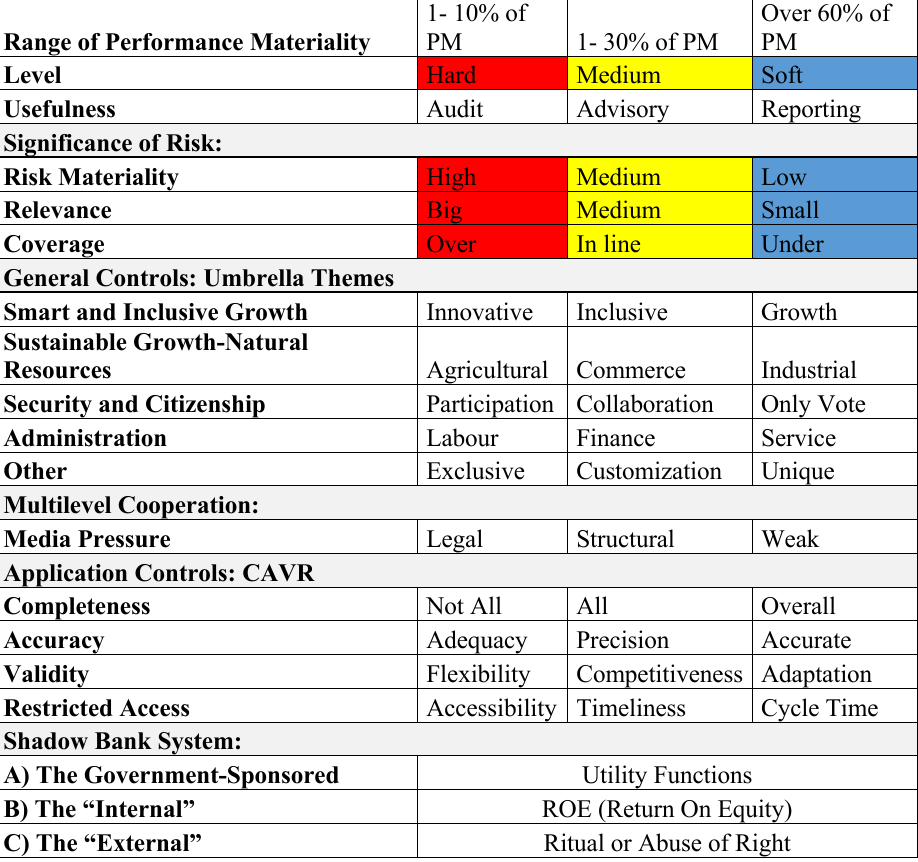
Table 1. Checklist of Internal Controls for Special Reports on European Shadow Bank